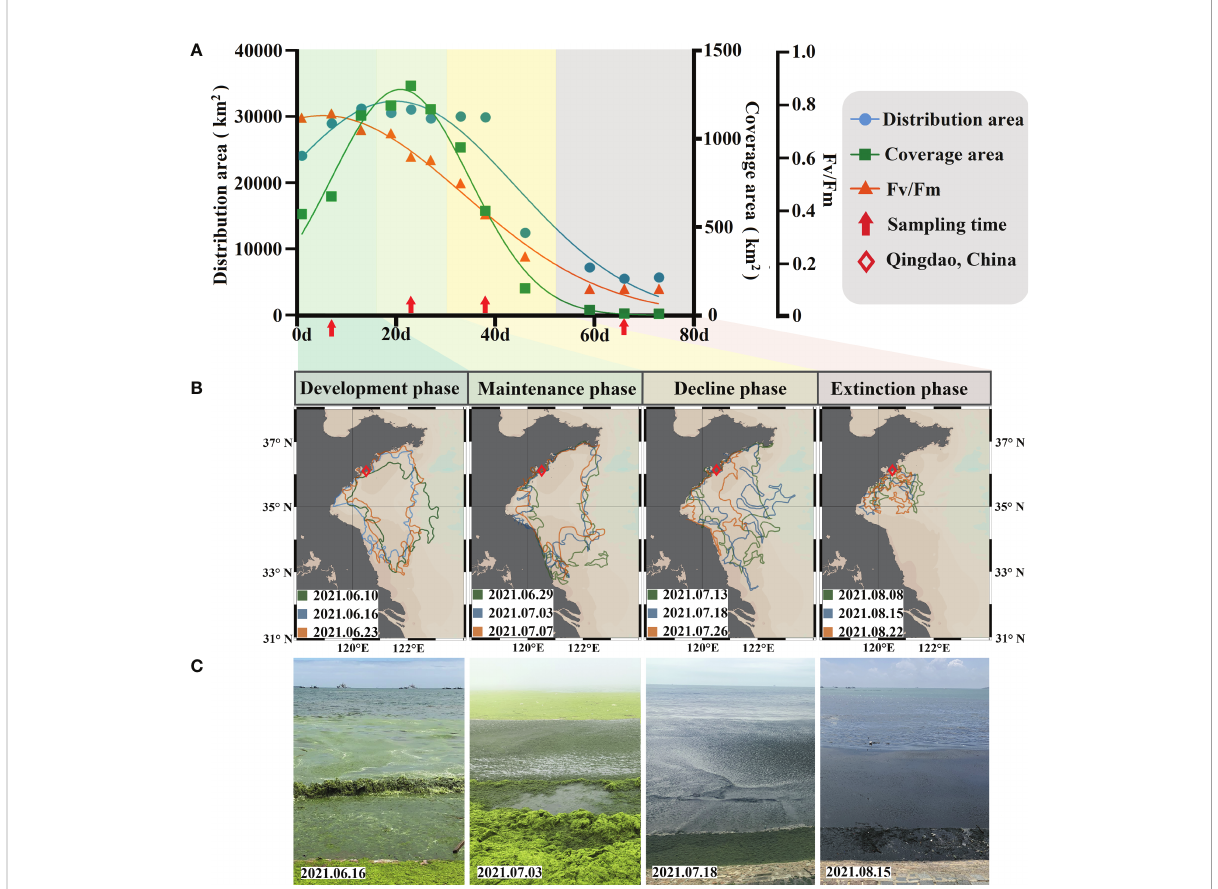
FIGURE 2 Information on the process of the U . prolifera green tide bloom and the phases. (A) Variations in the distribution area, coverage area, and algal physiological activity. (B) Phases of the green tide bloom. (C) Field conditions of the investigation during the different phases of the green tide